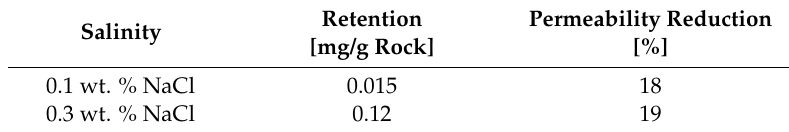
Table 6. Retained nanocellulose and permeability data for core flood retention experiments.